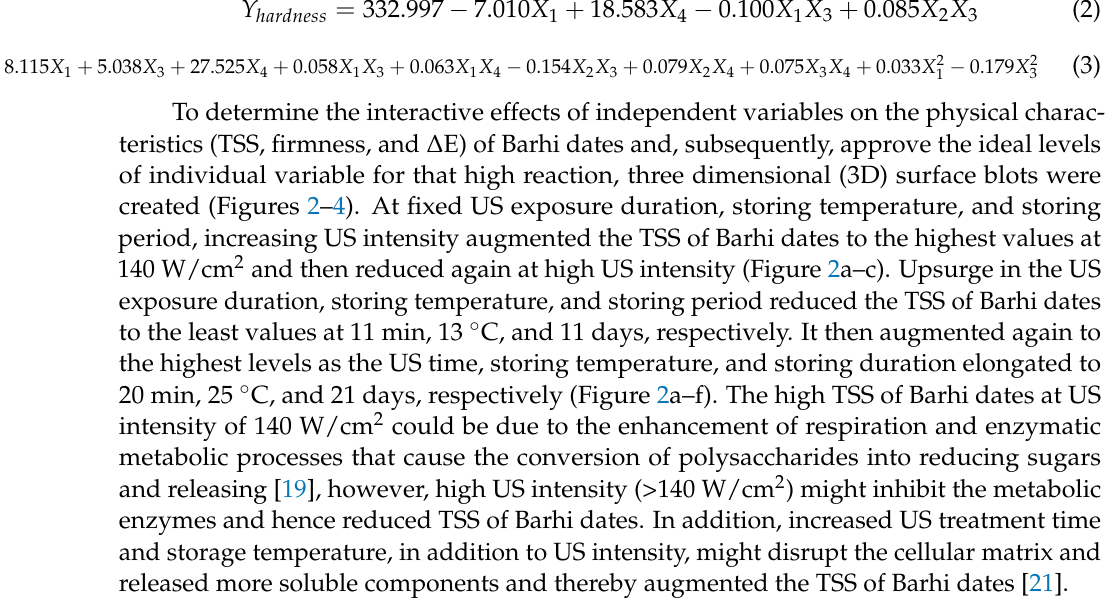
Figure 3. Response surface plots of firmness of Barhi dates as a function of US time and US intensity ( a ), storage temperature and US intensity ( b ), storage time and US intensity ( c ), storage temperature and US time ( d ), storage time and US time ( e ), and storage time and storage temperature ( f ).